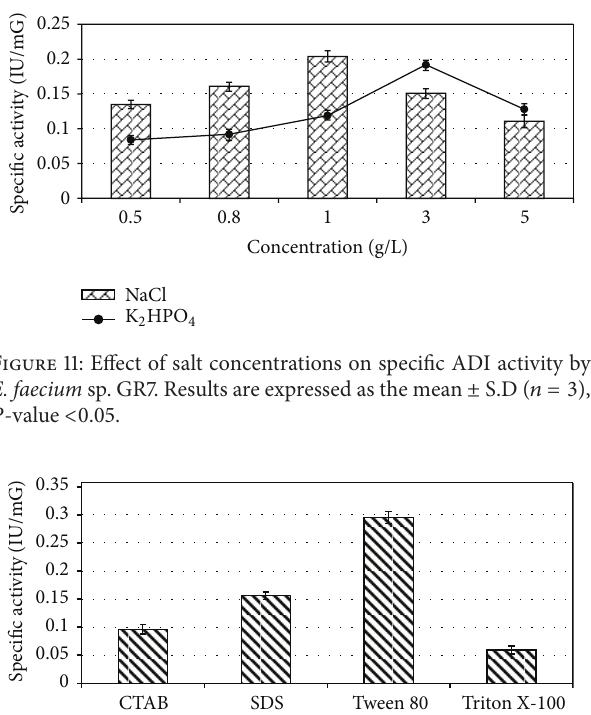
Figure 8: Effect of different nitrogen concentrations on enzyme production.Resultsareexpressedasthemean ± S.D( 𝑛 = 3 ), 𝑃 -value < 0.05.